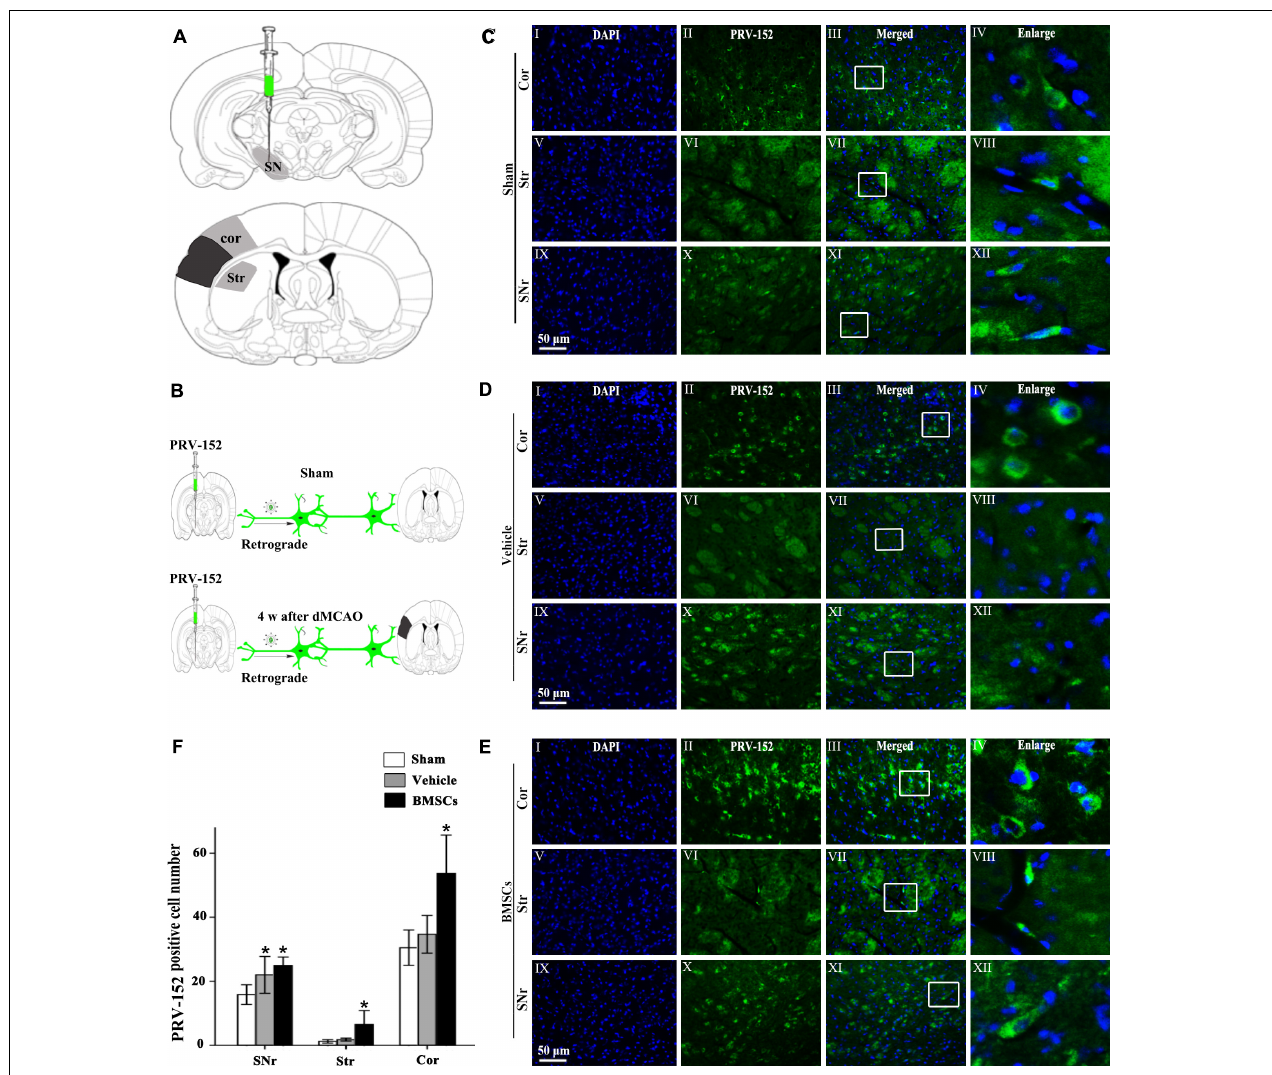
FIGURE 6 | Cortico-striatum-nigral tract retrograde tracing with PRV-152. (A) PRV-152 was injected into the ipsilateral SNr. Regions of interest (ROI) of PRV-152 positive cell counting were shown. Dark shaded area represents ischemic region after dMCAO; lighter shaded area represents ROI. (B) Schematic illustration of the fluorescent signal of PRV-152 in sham-operated and dMCAO groups with or without BMSCs transplantation after PRV-152 was injected into the ipsilateral SNr. (C) Representative photographs of fluorescent double staining of PRV-152 (green) and DAPI (blue) in the ipsilateral cortex (I–IV) , striatum (V–VIII) and SNr (IX-XII) at 4 days after PRV-152 injection in sham-operated group. (D) Representative photographs of fluorescent double staining of PRV-152 (green) and DAPI (blue) in the ipsilateral cortex (I–IV) , striatum (V–VIII) , and SNr (IX–XII) at 4 weeks after PRV-152 injection in vehicle group. (E) Representative photographs of fluorescent double staining of PRV-152 (green) and DAPI (blue) in the ipsilateral cortex (I–IV) , striatum (V–VIII) and SNr (IX–XII) at 4 weeks after PRV-152 injection in BMSCs group. Scale bar, 50 µ m. (F) Quantitative analyses of PRV-152 + cell number in the ipsilateral cortex, striatum and SNr after dMCAO. Transplantation with BMSCs increased PRV-152 + cells in the ipsilateral cortex [ F ( 2 , 19 ) = 9.85, p < 0.01], striatum [ F ( 2 , 41 ) = 10.67, p < 0.01] and SNr [ F ( 2 , 19 ) = 6.05, p < 0.01] after dMCAO. Each bar represents the mean ± SD ∗ p < 0.05 vs. sham-operated group and # p < 0.05 vs. vehicle group ( n = 7 in each group). SNr, substantia nigra pars reticulata; Cor, cortex; Str, striatum; PRV, pseudorabies virus; Sham, sham-operated; w, week; dMCAO, distal middle cerebral artery occlusion; BMSCs, bone marrow stromal cells; DAPI, 4’, 6-